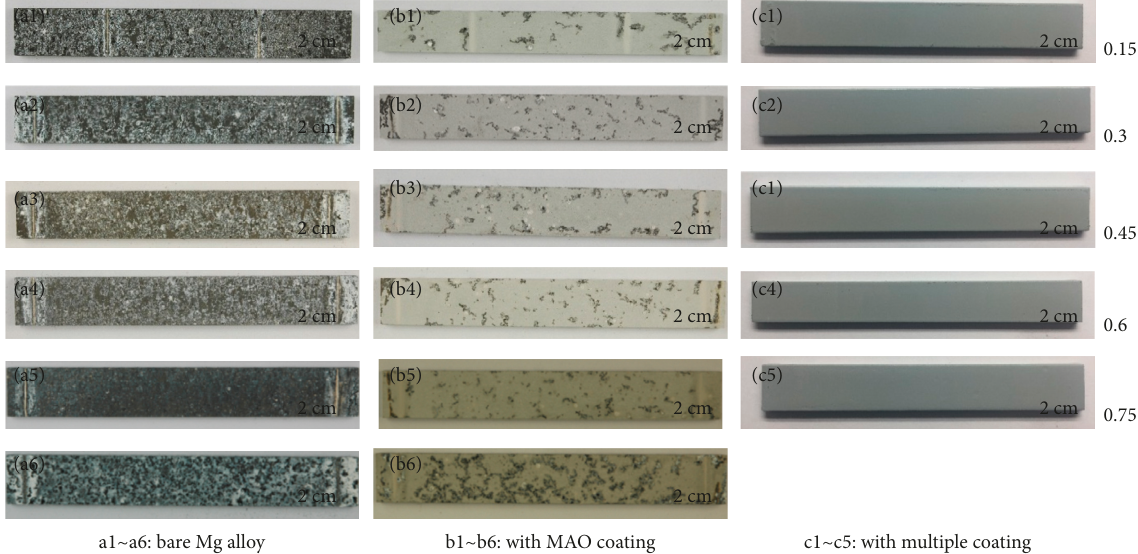
Figure 6: Digital macroscopic pictures of the AQ80M Mg alloys with different conditions: a1 ∼ a6: bare Mg alloy, b1 ∼ b6: with MAO coating, and c1 ∼ c5: with multiple coating.